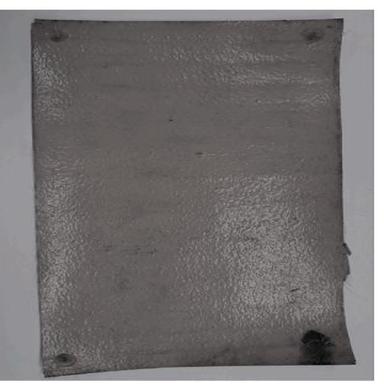
CSR thermal barrier material used inside the battery pack.